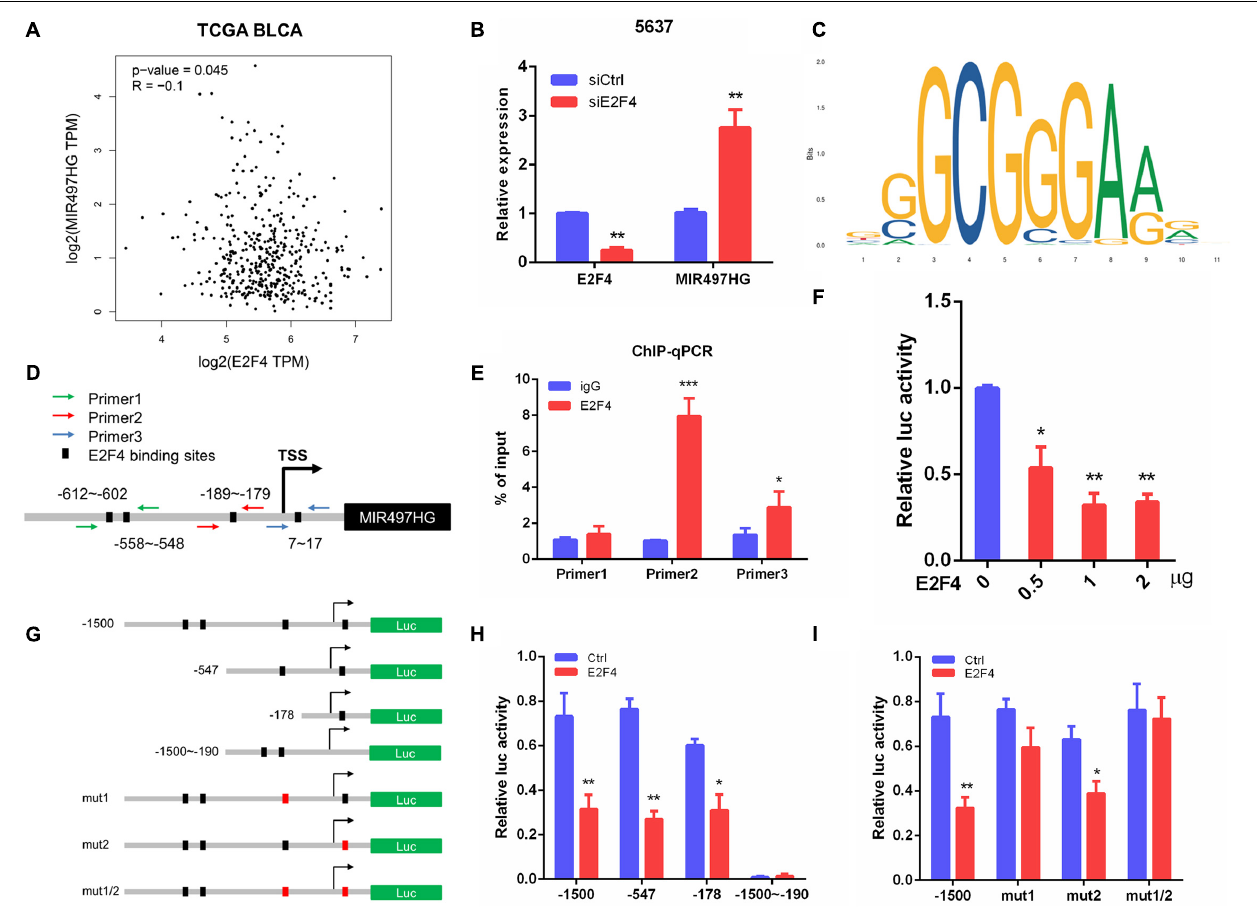
FIGURE 6 | E2F4 transcriptionally repressed MIR497HG expression in BCa cells. (A) The correlation between E2F4 gene expression and MIR497HG level in TCGA datasets. (B) 5637 cells expressing either E2F4 or non-silencing control siRNA were analyzed for E2F4 (left) or MIR497HG (right) mRNA expression using qRT-PCR. (C) E2F4-binding motif. (D) E2F4 binding in the MIR497HG promoter and primer designation. (E) Chromatin immunoprecipitation was performed in 5637 cells with either IgG or E2F4 and subsequently subjected to qPCR analysis with the indicated primers. Student t test, * P < 0.05 and *** P < 0.001. (F) HIF-1a promoter activity was determined in 5637 with E2F4 overexpression. One-way ANOVA with Dunnett posttest, * P < 0.05 and ** P < 0.01. (G) A schematic representation of deletion or mutation constructs spanning the − 1,500 to + 200 region of the MIR497HG promoter. (H, I) The luciferase vector pGL3 driven by either wild-type, deletion, or mutant MIR497 promoter was transfected in 5637 cells, and luciferase activity was measured. n = 3 independent experiments. * P < 0.05 and ** P < 0.01 by Student t